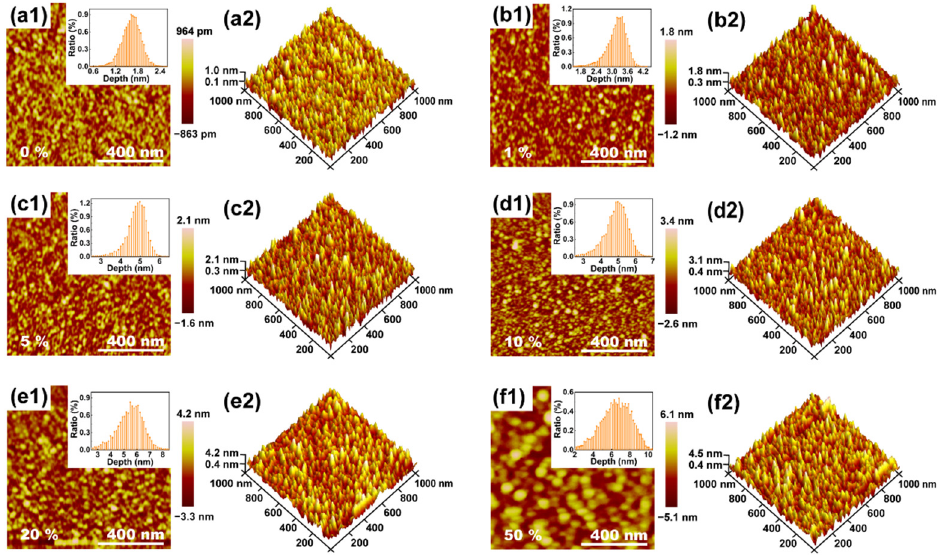
Figure 4. AFM representations of the 2D and 3D morphology of the Ga 2 O 3 thin films with ( a1 , a2 ) 0%, ( b1 , b2 ) 1%, ( c1 , c2 ) 5%, ( d1 , d2 ) 10%, ( e1 , e2 ) 20%, and ( f1 , f2 ) 50% Sn content. The corresponding depth distribution images are shown in the inset of ( a1 – f1 ).